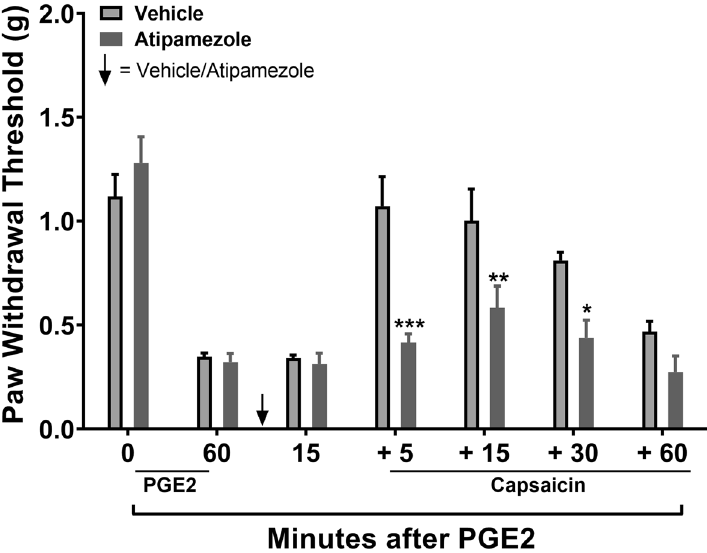
Figure 2. Assessment the role of norepinephrine signaling in diffuse noxious inhibitory control (DNIC) in naive mice. The α2 adrenoceptor antagonist, atipamezole (ATZ) given systemically prior to injection of the conditioning stimulus, capsaicin, in naïve male mice had no effect on the PGE-2-induced sensitization. However, ATZ did block the DNIC response to capsaicin in non-injured mice. Data were analyzed by two-way repeated measures ANOVA using the Sidak method to correct for multiple comparisons. * p < 0.05, ** p < 0.01, *** p < 0.001 indicates significant difference between vehicle and drug treatment groups. Error bars: SEM, n = 6/ group.